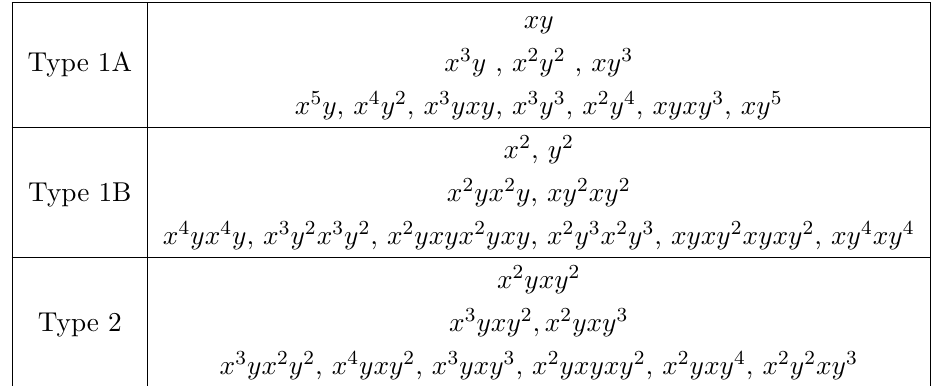
Table 3 . Lowest order examples of the three distinct types of ‘orthogonal’ Lyndon words.